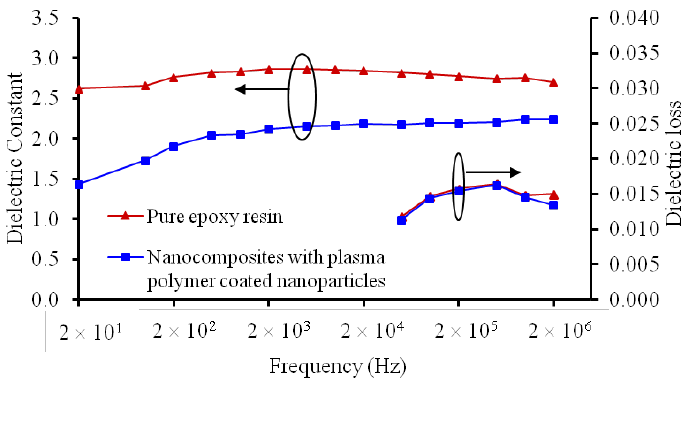
Figure 11. Comparison on dielectric constant and dielectric loss of the pure epoxy